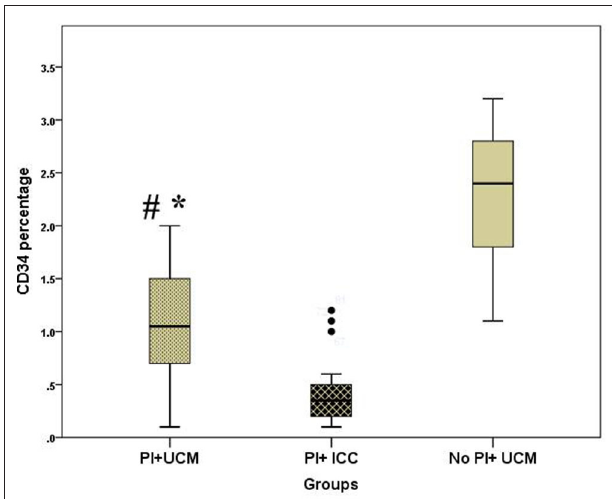
FIGURE 1 | Box and whisker plot demonstrating peripheral blood CD34 percentage of the studied groups; PI + UCM (placental insufficiency and umbilical cord milking), PI + ICC (placental insufficiency and immediate cord clamping, No PI + UCM (no placental insufficiency and umbilical cord milking), * p < 0.05 compared to No PI + UCM, # p < 0.05 compared to PI + ICC.